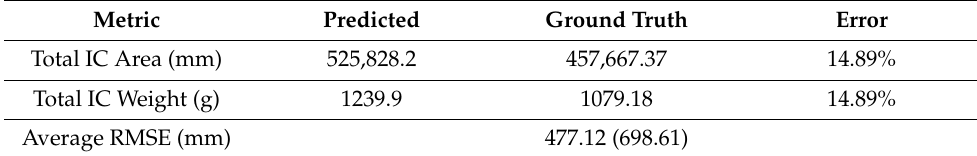
Table 4. WPCB’s total IC area and weight.